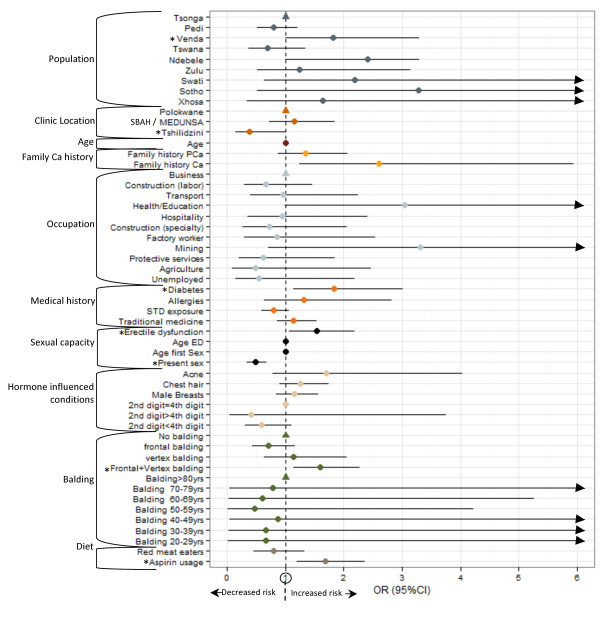
Multiple logistic regression analysis for association between multiple variables and prostate cancer risk. For each variable, odds ratios (ORs) are represented by dots and Confidence intervals (CI) are represented by horizontal lines extending from dots. Dots are color coded according to variable groupings indicated on left hand side of Y-axis. Reference groups for variables with multiple outcomes are represented by a single triangle (no CI) positioned along the Y-axis at X = 1. The X-axis limit was set at a value of 6.0. CI exceeding this limit are indicated by arrows. PSA levels are not represented on this plot due to values exceeding this limit. *indicates variable is associated with over-all prostate cancer risk at a significance level <0.05.